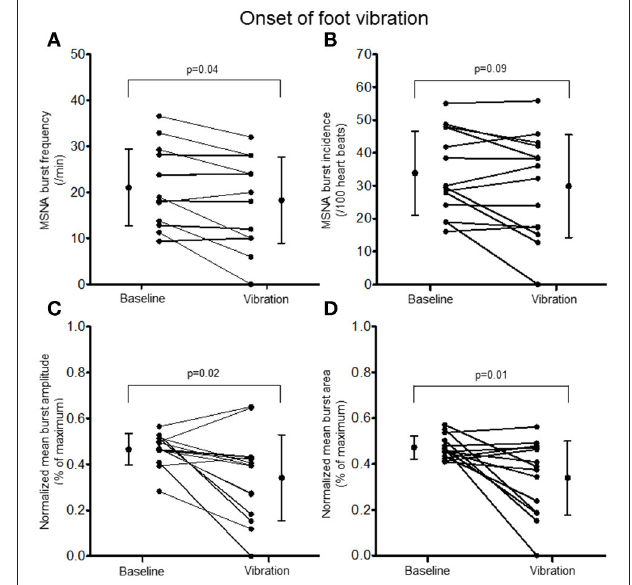
FIGURE 5 | Muscle sympathetic nerve activity (MSNA) burst frequency (A) , burst incidence (B) , and normalized mean burst amplitude (C) and area (D) during 2 min of baseline rest and the onset (10 s) of hand vibration.